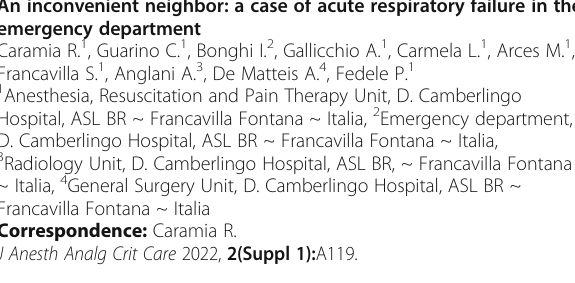
Table 1 (abstract A18). See text for description (Continued) First author,